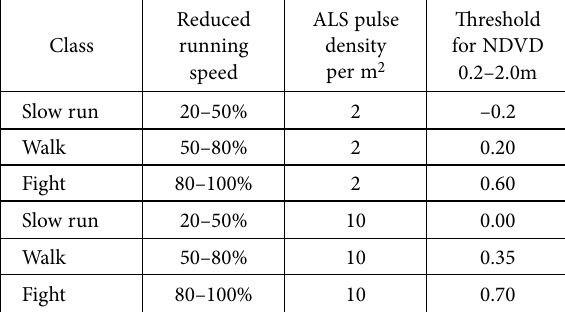
Table 5. Threshold values used in the estimation of forest runability from the NDVD of the 0.2 to 2.0 m vegetation